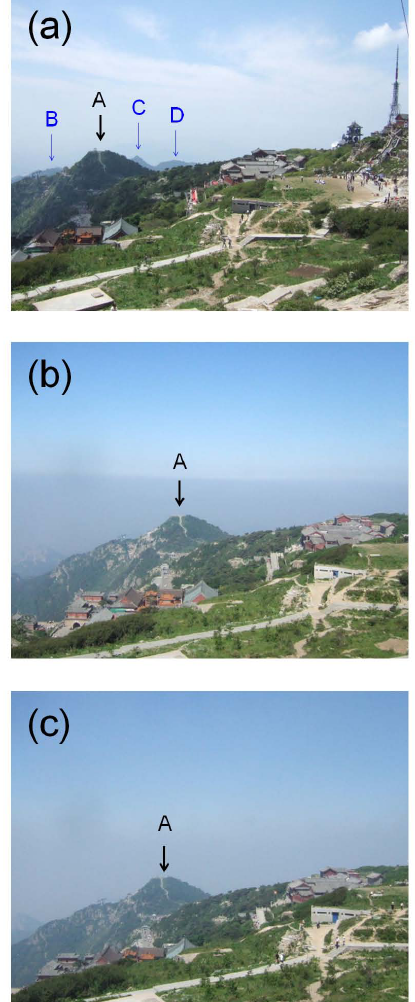
Fig. 7. Photographs taken from the observatory looking westward. (a) Day with good visibility. (b) Pollution layer seen below the mountain in the morning. (c) Polluted boundary layer builds up in the morning and covers the mountain top before